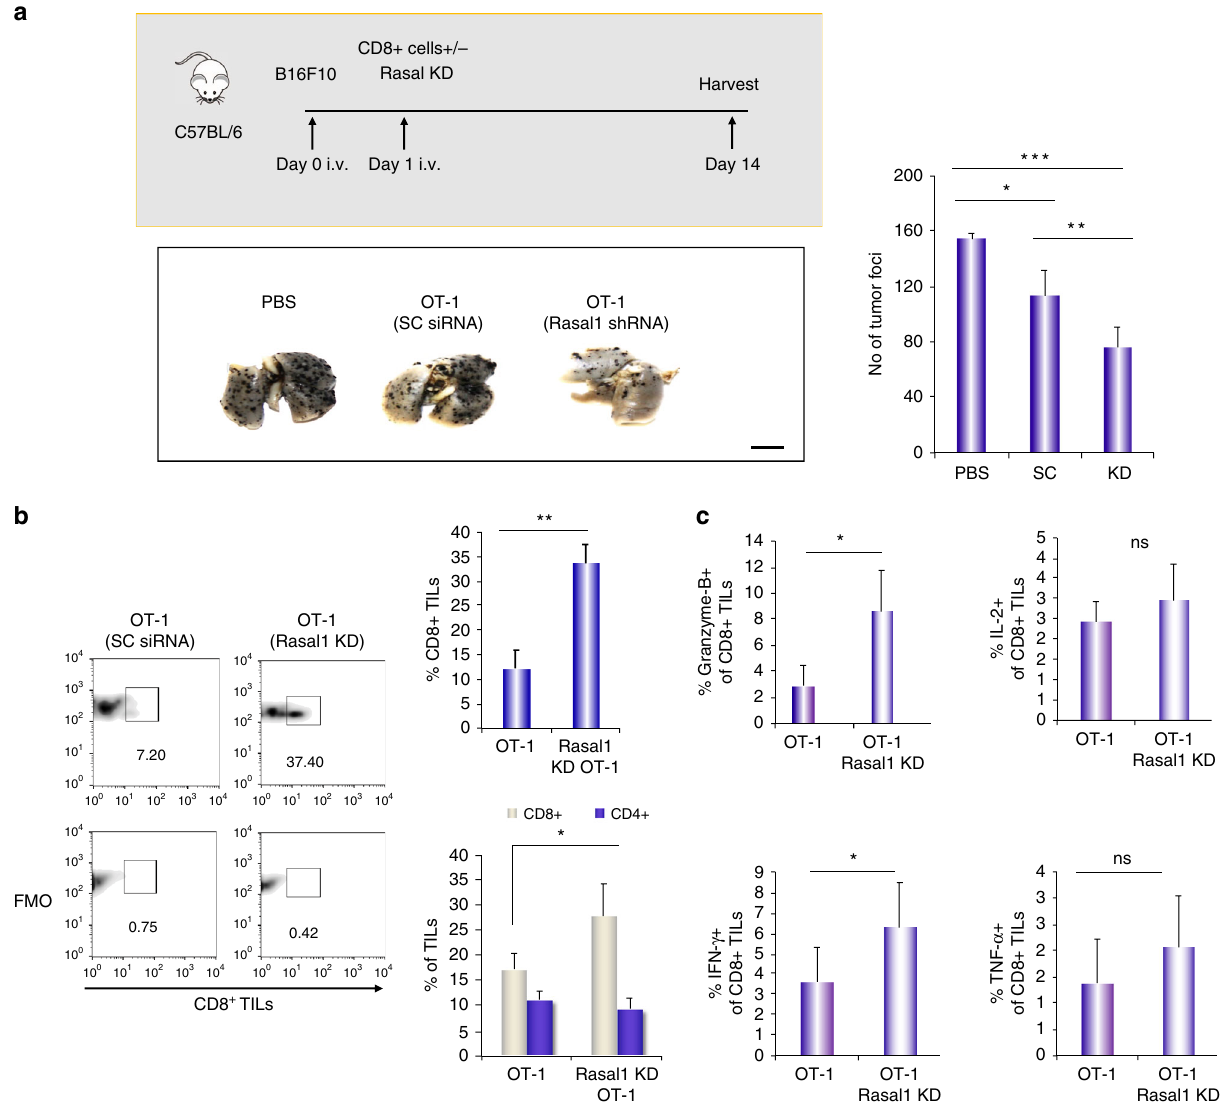
Fig. 7 Rasal1 KD T cells show enhanced rejection of B16 tumors and the increased presence of activated CD8 + TILs. a Schematic of B16 melanomas tumor experiment. Histogram of B16 tumor foci at day 14 in control versus or mice receiving OT-1 cells with control scrambled esiRNA or with Rasal1 esiRNA ( n = 4 per group, upper panel). Lower panel: representative image of B16 tumor lungs from each group. Right panel: histogram showing Rasal1 KD reduction of tumor foci in pulmonary B16 metastasis (numbers of tumor foci in lungs) ( n = 3) (scale bar, 10 mm). b Rasal1 KD adoptive cell transfer results in a major increase in CD8 + TILs in B16 tumors. Left panel: FACs histograms showing presence of CD8 + TILs in tumors. SC scrambled siRNA, Rasal1 KD Rasal1 siRNA. Right upper panel: histogram showing percentage of CD8 + TILS; lower right panel: percentage (%) of CD4 vs CD8 T-cells in lung tumors of B16 animals. c Rasal1 KD ACT results in an increase in the GZMB and interferon gamma expressing CD8 + TILs in B16 tumors. Histograms showing % of granzyme B (GZMB), IFN- γ , IL-2, and TNF- α expressing CD8 + TILs. Plots show mean with ± SD. p -values were calculated by unpaired t test. * p < 0.05, ** p < 0.01, *** p <